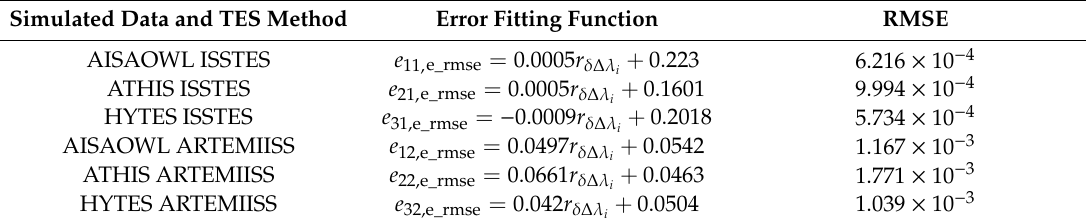
Table 6. The LSE error fitting function about FWHM change